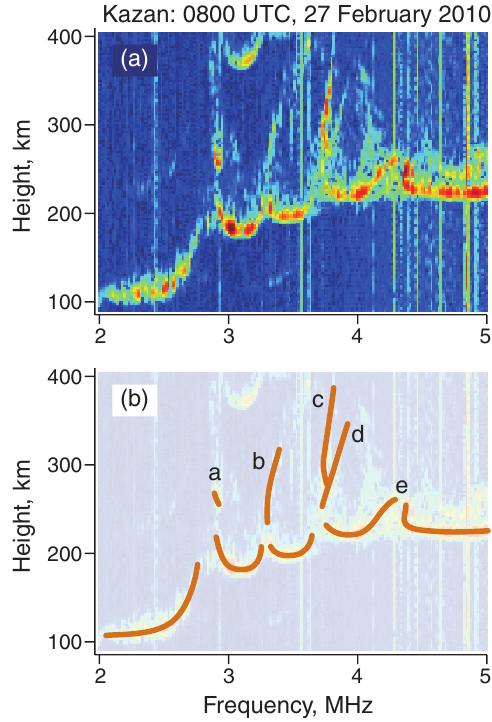
Figure 3. Enlarged ionogram showing cusp section of Fig. 2c (a) and sketch of O-mode trace (b) . Several interesting episodes are denoted by the letters (a) to (e).